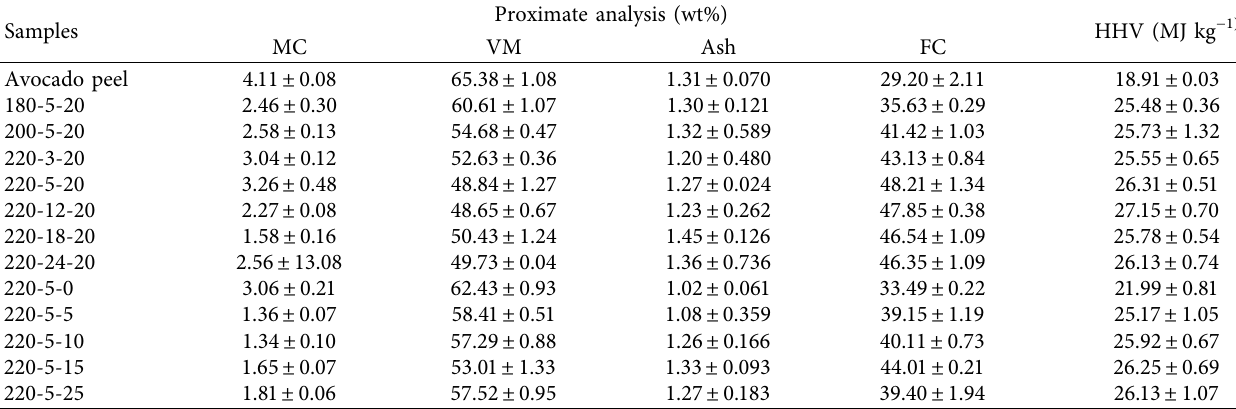
Table 2: Results of proximate analysis for feedstock and different hydrochars.